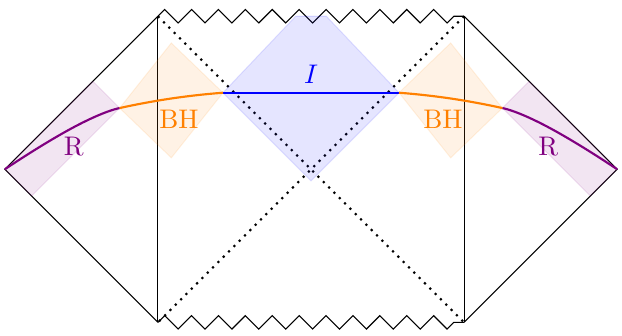
Figure 1 . The Penrose diagram of the AdS black hole attached to the non-gravitating heat bath. We take the radiation region R (violet solid line) in the heat bath. After the Page time, the island region I (blue solid line) becomes non-empty, and the black hole region BH (orange solid line) is outside the horizon of the black hole. The entanglement wedge of the Hawking radiation R is the union of the domain of dependence of the radiation R and island I regions (violet and blue shaded regions), and that of the black hole BH is the domain of dependence of the black hole region (orange shaded